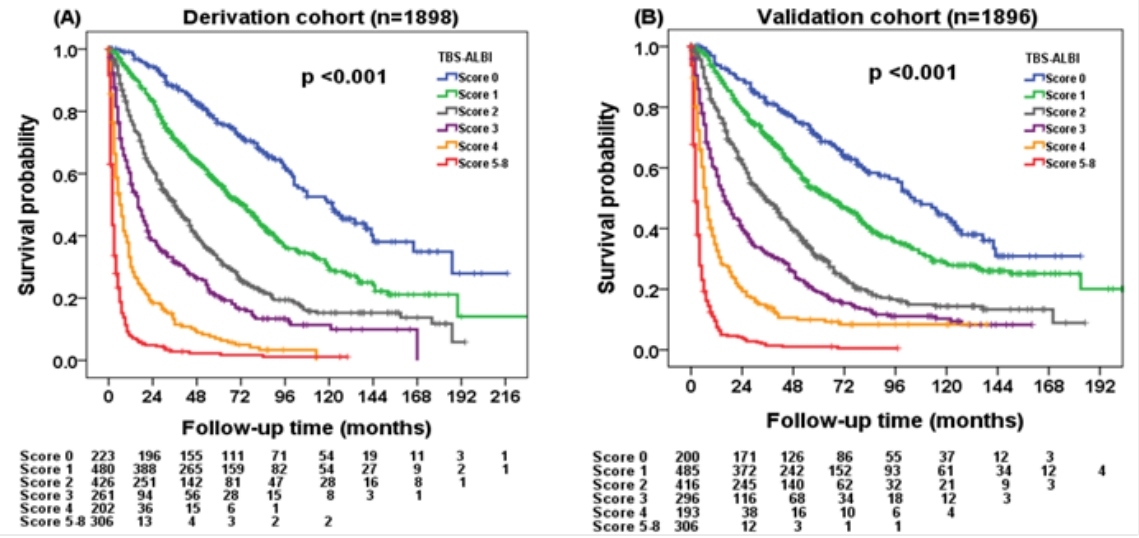
Figure 2. Kaplan–Meier analysis of the TBS- and ALBI-grade-based prognostic model (TBS–ALBI system) in the ( A ) derivation and ( B ) validation cohorts. There were significant survival differences in different TBS–ALBI score risk groups in the derivation cohort ( p < 0.001; n=1898). Patients with high TBS–ALBI scores consistently had decreased overall survival in the validation cohort ( p < 0.001; n=1896).